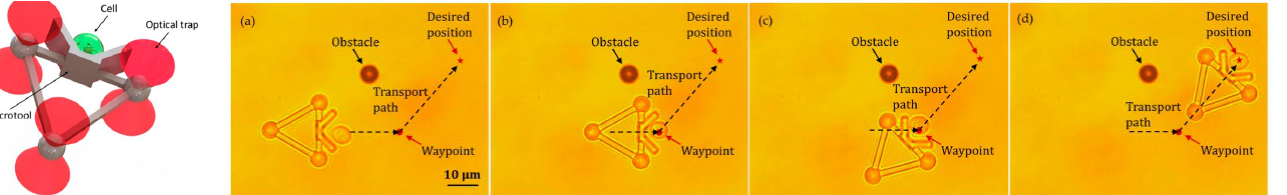
Figure 8. The indirect transportation of biological cells with HOT [60]. ( a ) Three-spots HOTs trap and move the microtool. The microtool push the cell. ( b ) The cell is carried to the waypoint to avoid the obstacle. ( c ) The moving direction of the microtool is redirected to the desired position. ( d ) Cell is transported to the desired location.